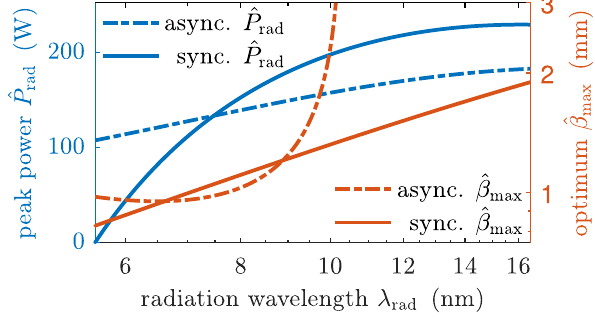
ˆ β FIG. 8. Maximum for a matched beam in an asynchronous max DLA undulator with E 0 ¼ 10 GV = m laser field strength at optimum FODO cell length. In comparison to the synchronous ˆ β ≈ 0 . 55 mm is larger, but the design the minimum of at λ max und undulator parameter K async does not vanish. und